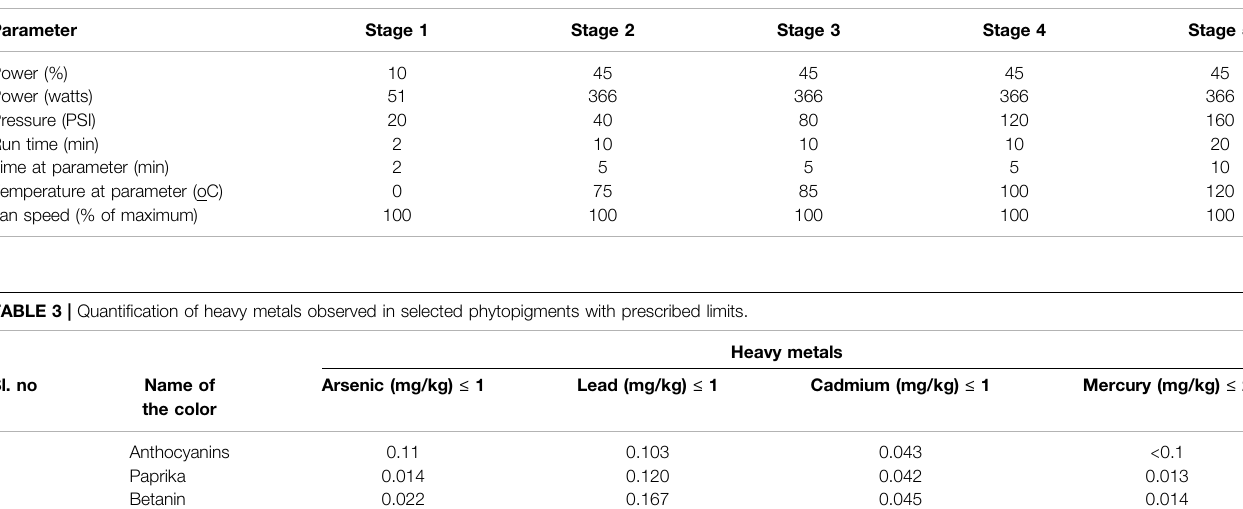
TABLE 2 | Microwave digestion parameters for phytopigment analysis. Parameter